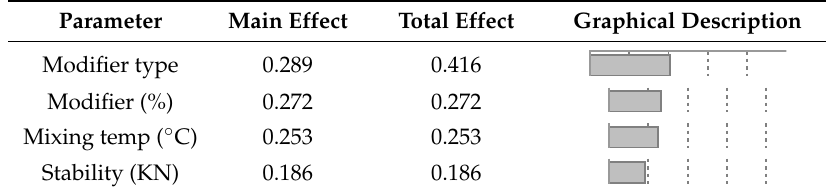
Table 8. Variable importance analysis.